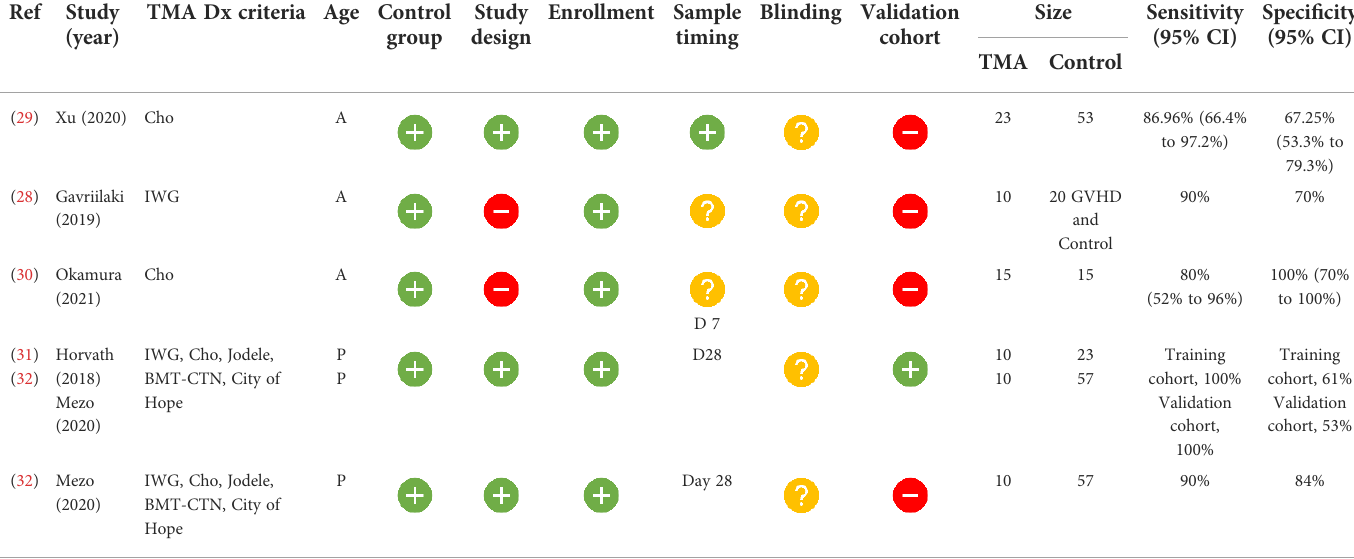
TABLE 2 a -group